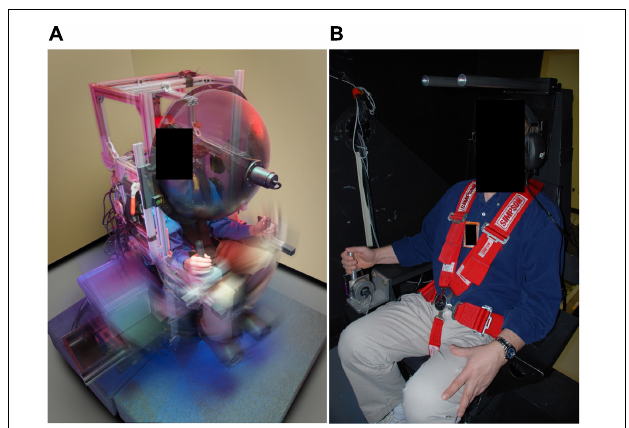
FIGURE 1 | (A) Roll tilt The variable radius centrifuge consisted of a servo-controlled rotator with a small linear track to provide dynamic translation of the chair during constant velocity rotation. Controlling the joystick with their right hand, subjects attempted to keep the chair in the center of the lateral translation stage (maintain a perceived upright orientation). (B) Pitch tilt Subjects sat in a chair that tilted in pitch about the interaural axis while they performed a closed-loop nulling task in which they used a joystick to null out perceived tilt motion. Photo credit: